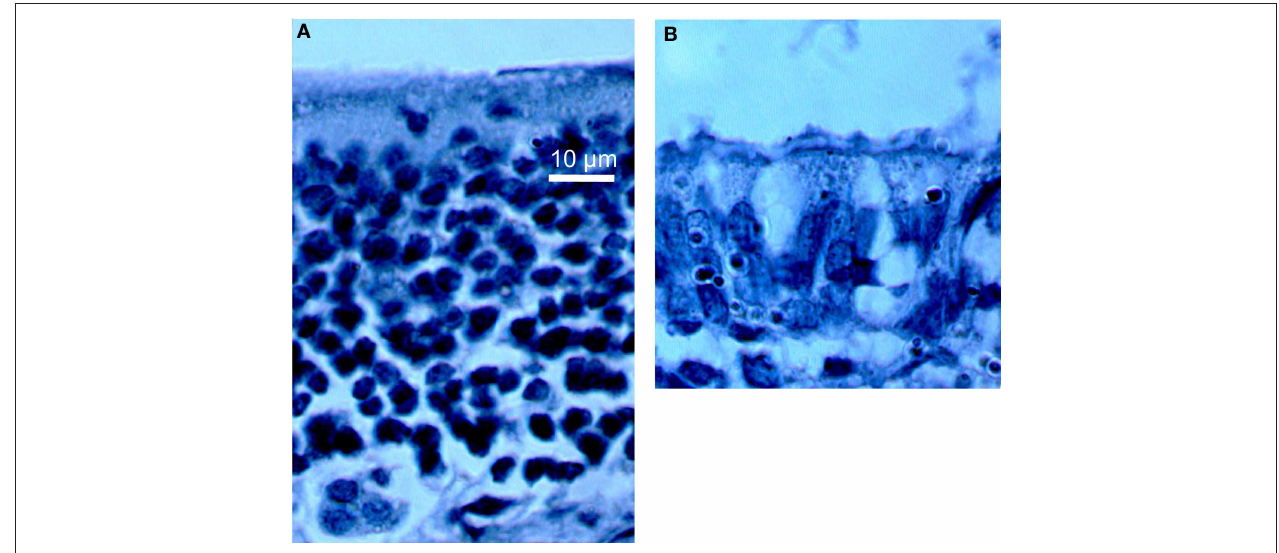
Figure 1 | Histological aspect of olfactory epithelium before (A) and 3 days after (B) intranasal perfusion (100 × enlargement) indicating a decrease of the epithelium thickness and an important loss of cells in